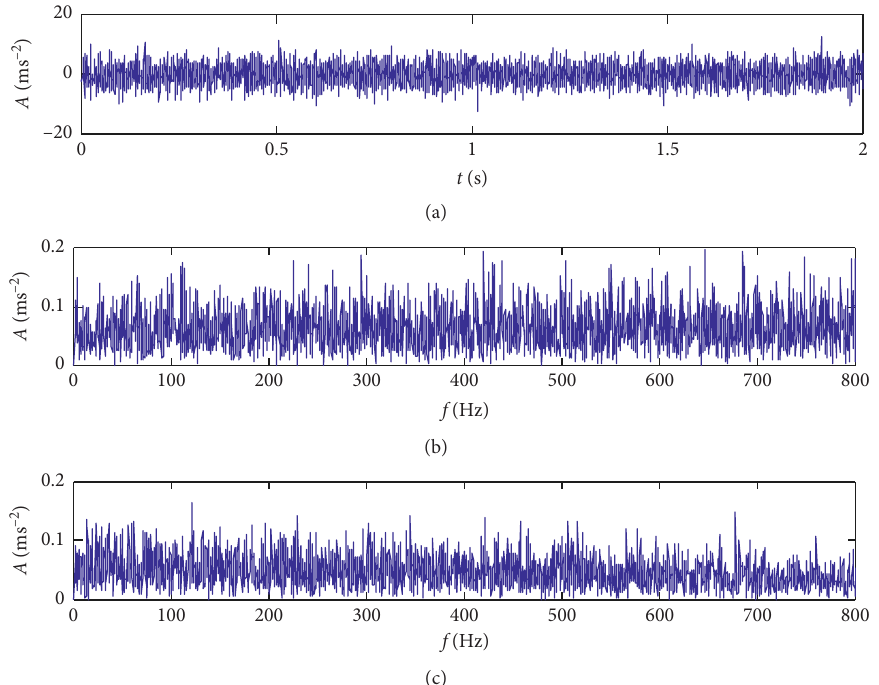
Figure 9: Rolling bearing signal: (a) original signal; (b) spectrum; (c) envelope spectrum.